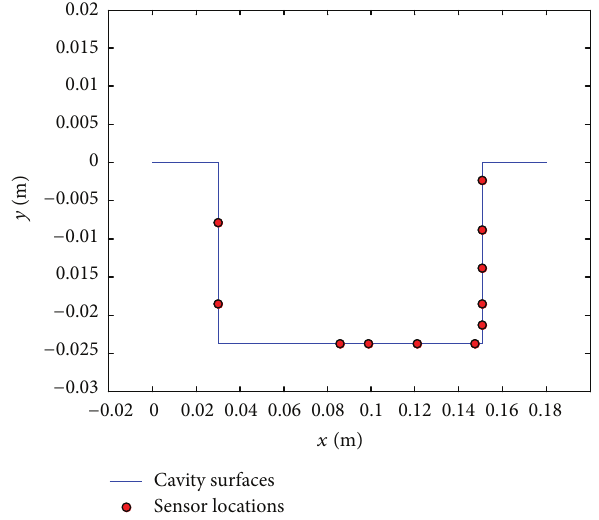
Figure 10: Final sensor placement on the cavity